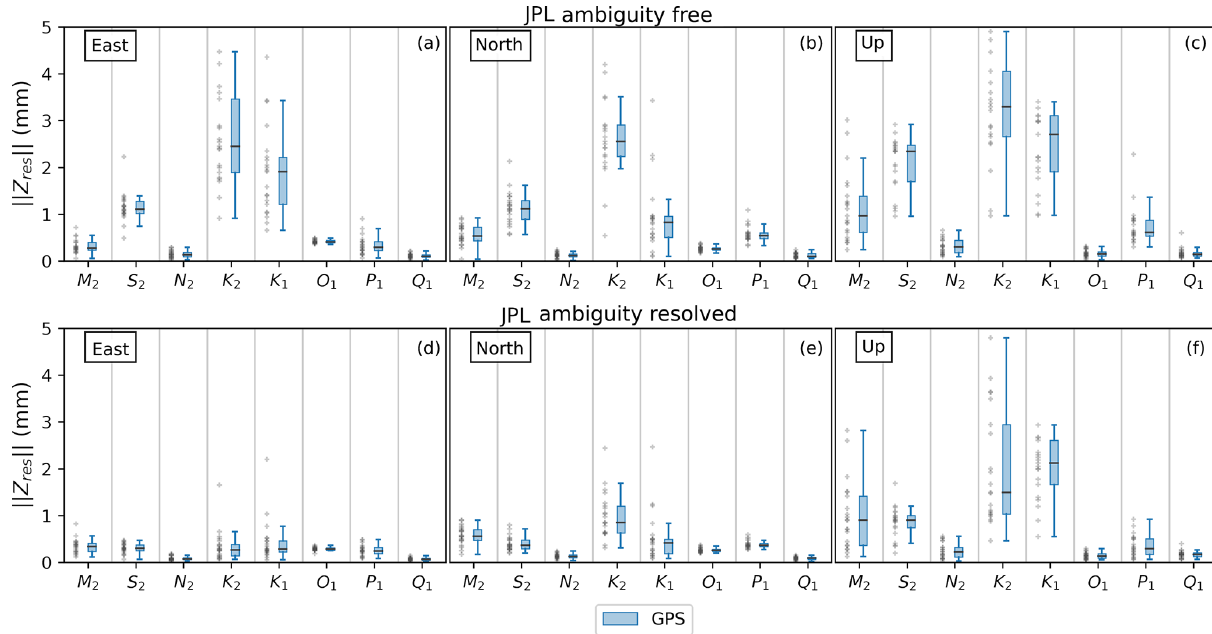
Figure 9. Comparison of residual constituents’ estimates from GPS (a–c) and GPS AR (d–f) JPL native solutions. Grey crosses are as per Fig. 3. As seen, most of constituents’ (cid:107) Z res (cid:107) distribution variances and medians are smaller, while S 2 (cid:107) Z res (cid:107) bias is removed with AR solutions.